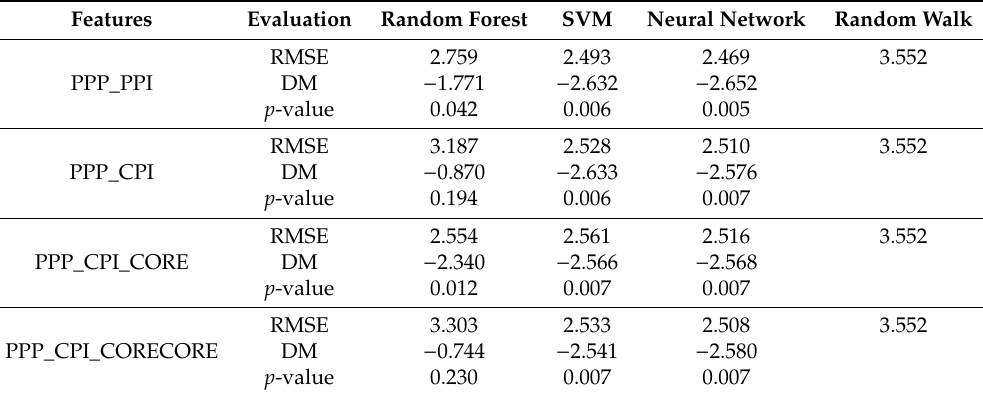
Table 3. Results for the purchasing power parity (PPP)